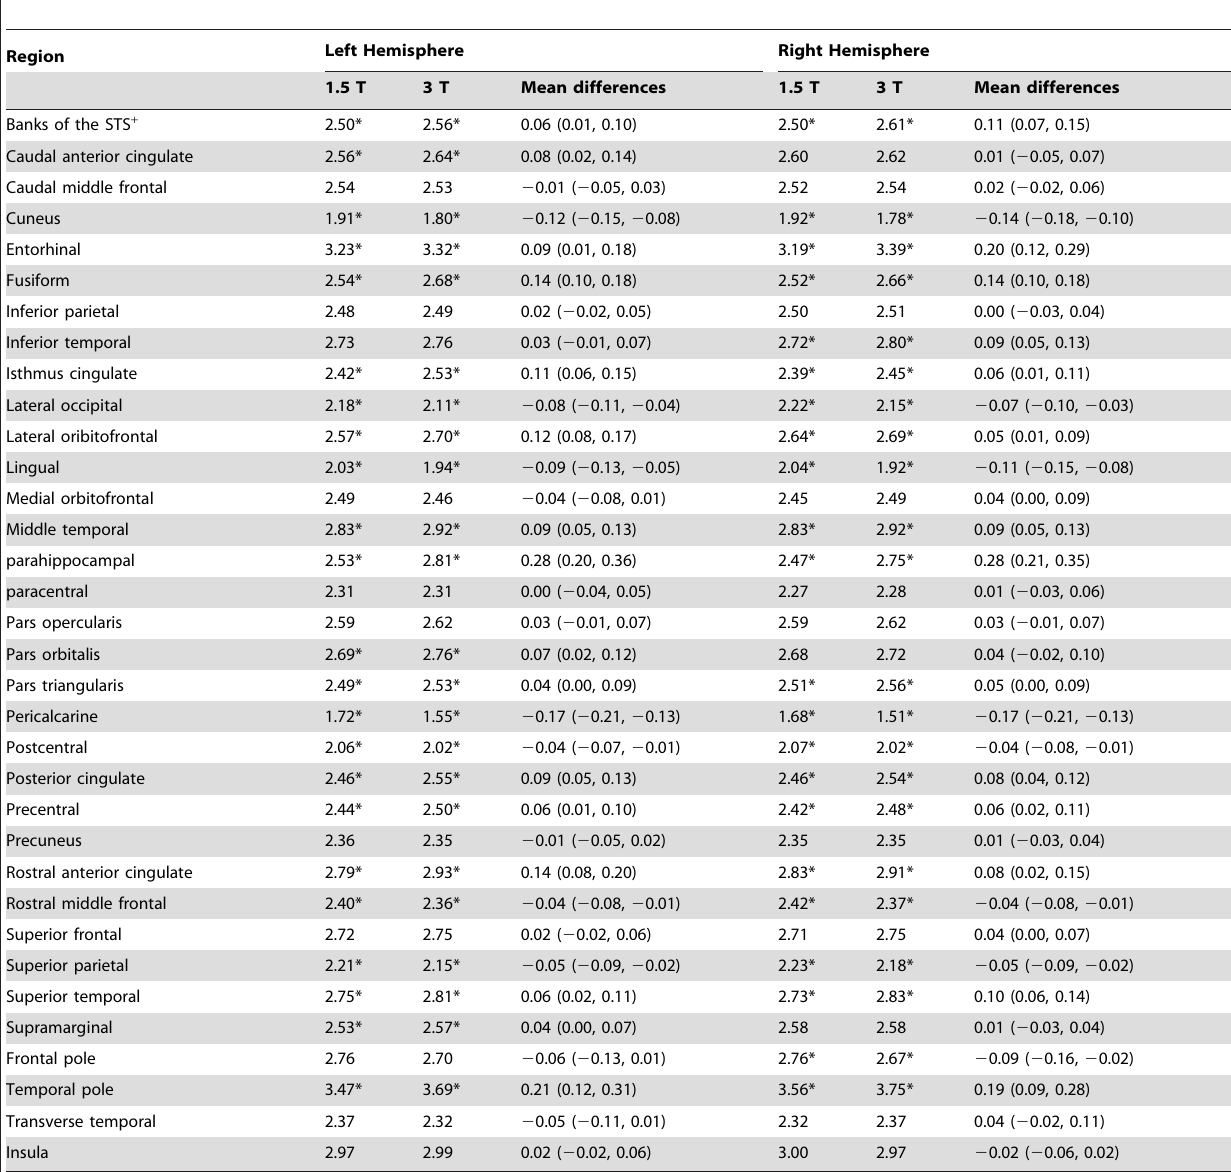
Table 4. Unadjusted means and mean differences (95% confidence interval) of regional cortical thickness by field strength (1.5 T vs. 3 T) for right and left hemispheres in 295 controls using multivariate regression